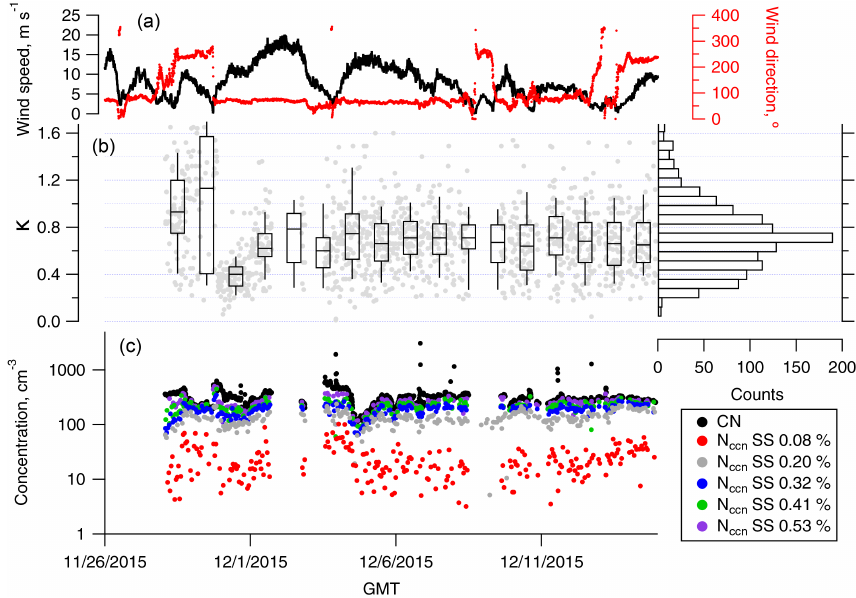
Figure 11. Panel (a) shows the time series of wind speed (black line) and direction (red markers) at the CASLab. Panel (b) shows the time series of the hygroscopicity parameter κ . The box-and-whisker plots summarise the variability in κ for each day, while the right panel shows a histogram of κ for the whole measurement period. Panel (c) shows the total condensation nuclei concentration (30 to 500nm, black dots) and the CCN concentrations at five different supersaturations (SSs, coloured dots from 0.08 to 0.53%). Dates are indicated in mm/dd/yyyy